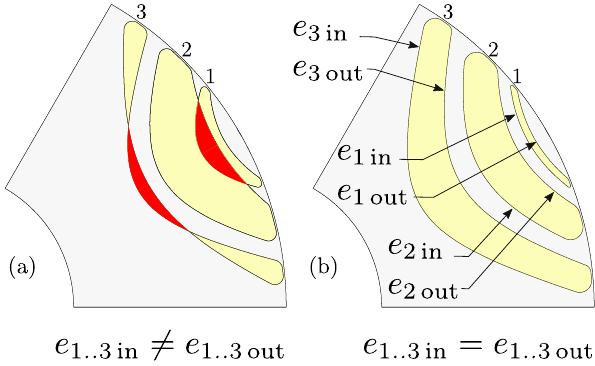
Figure 3. Illustration of infeasible ( a ) and feasible geometry ( b